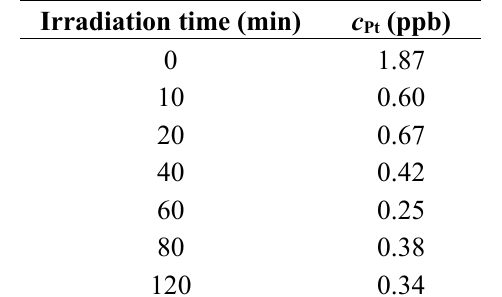
Table 1. Concentration of platinum in the supernatant (dissolved from TiO 2 surface) as a function of irradiation time (total concentration of platinum in the suspension is 10,000